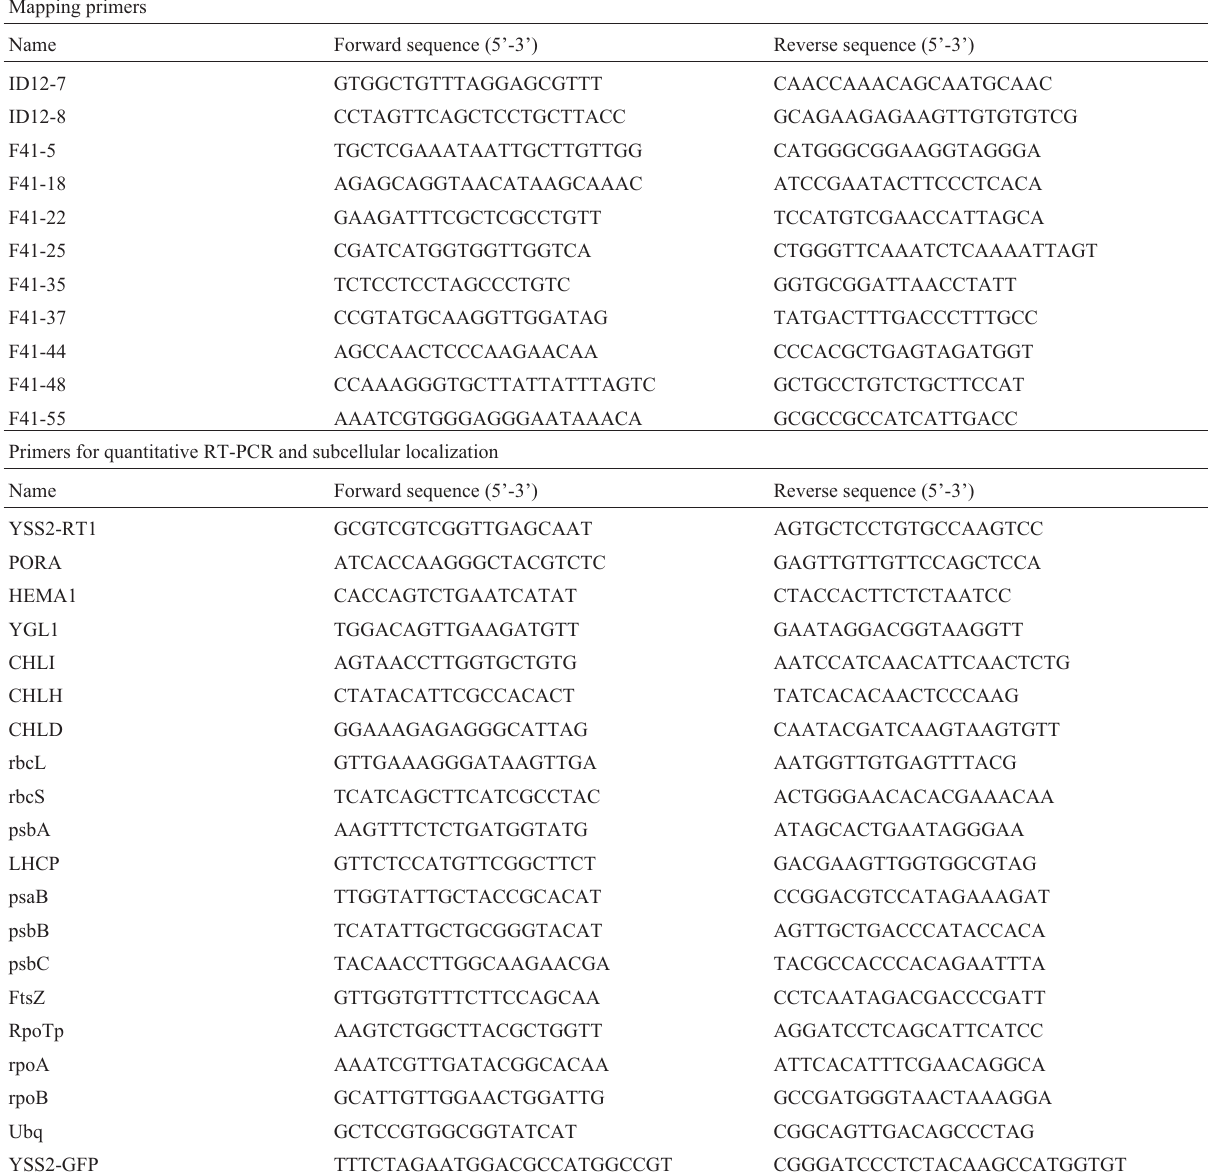
Table 1 - Primer sequences used in this